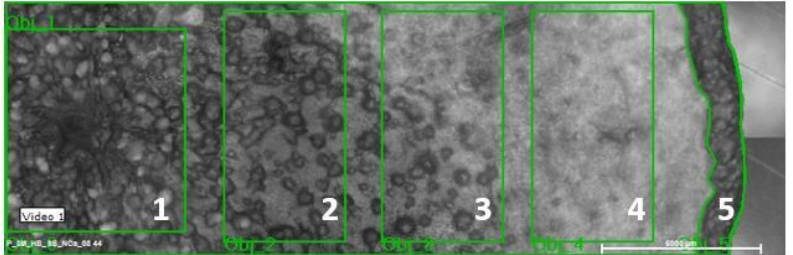
Figure 1. Example of a sliced sample of Rocha pear fruits with a stainless-steel blade. Green lines delineate different zones for minerals assessment (from center to epidermis, zones 1 to 5, respectively).